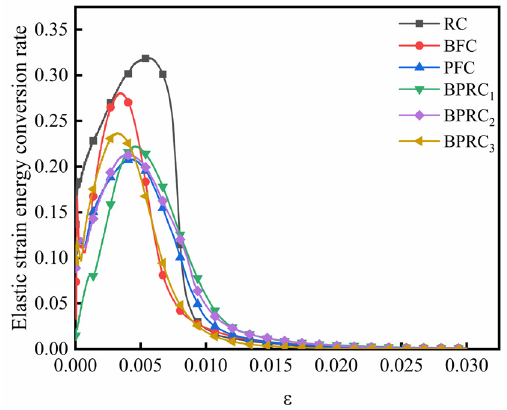
Figure 10. The conversion rate of elastic strain energy.